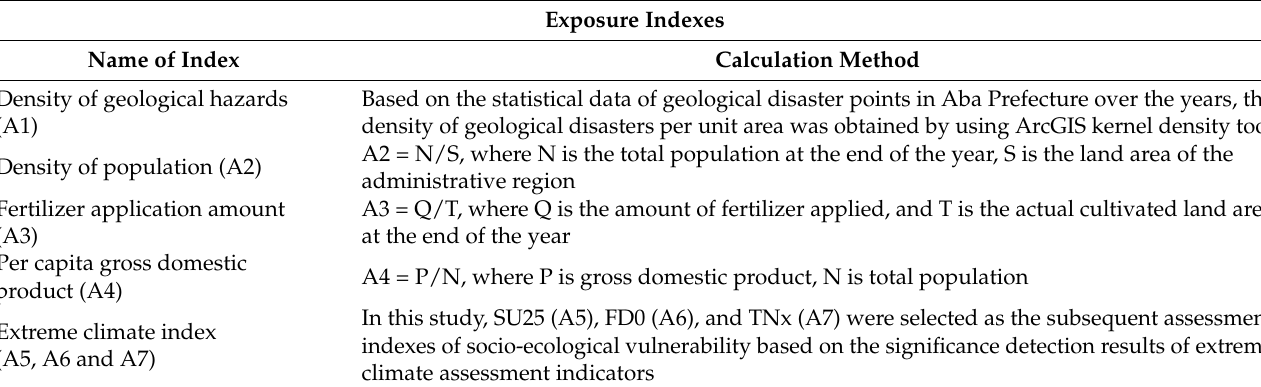
Figure 3. Index system for socio-ecological vulnerability evaluation. Table 2. Calculation method of exposure indexes.